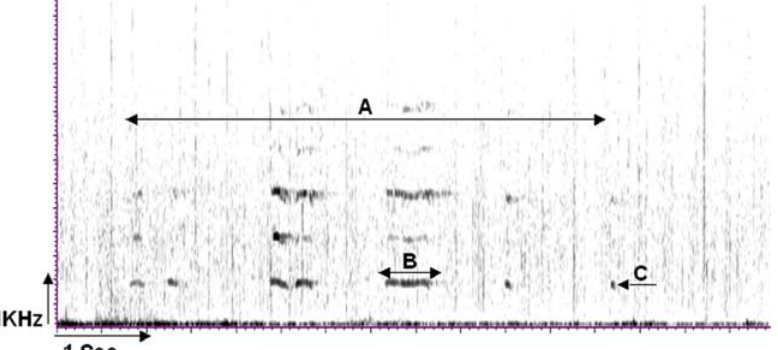
Figure 5. Copulation call spectrogram. Time-frequency spectrogram of a female copulation call from Budongo Forest during maximum tumescence. Filter bandwidth: 159 Hz, Frequency resolution: 86.1 Hz. Depicted is (A) the total copulation calling bout of approximately 6.5 s and (B) a single copulation call of approximately 0.6 s by the female JL. (C) The lowest visible band is the fundamental frequency from which acoustic measurements were taken with three visible harmonic bands. Copulation calls have a frequency range of 700–1000